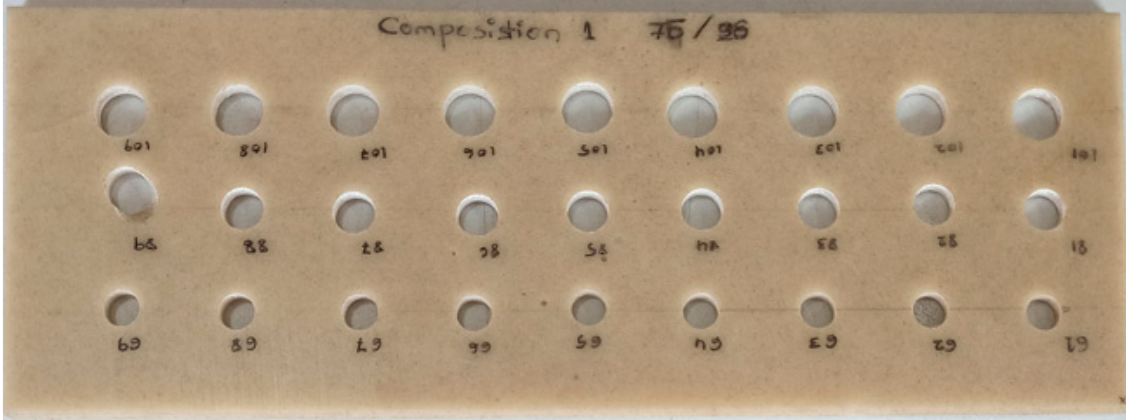
Figure 4. Fabricated composite with different diameter holes.